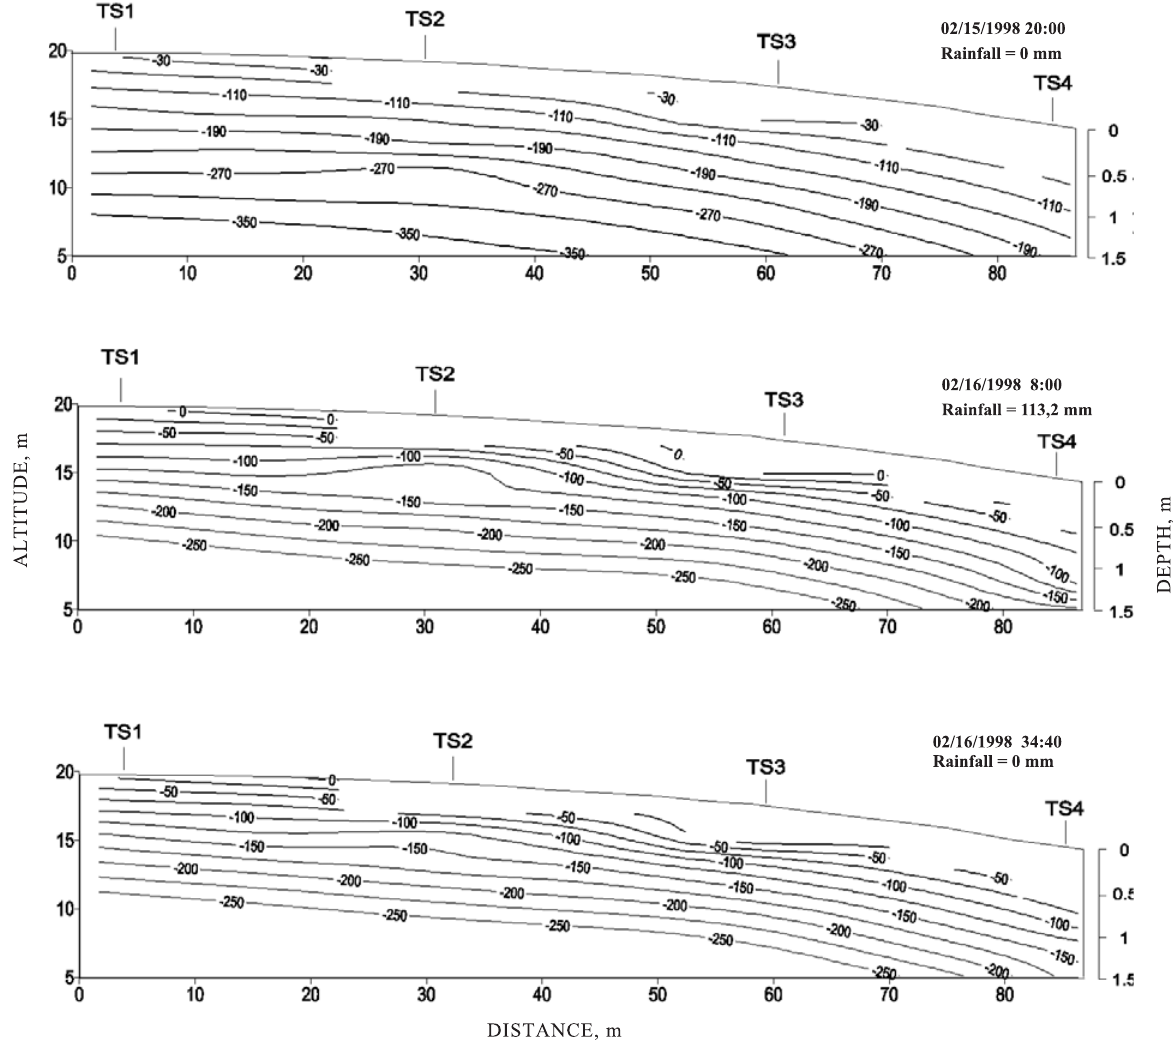
Figure 9. Total water potential head variations during a rainstorm in the morning of 16/2/1998. Isolines in hPa were made using geostatistical gridding methods